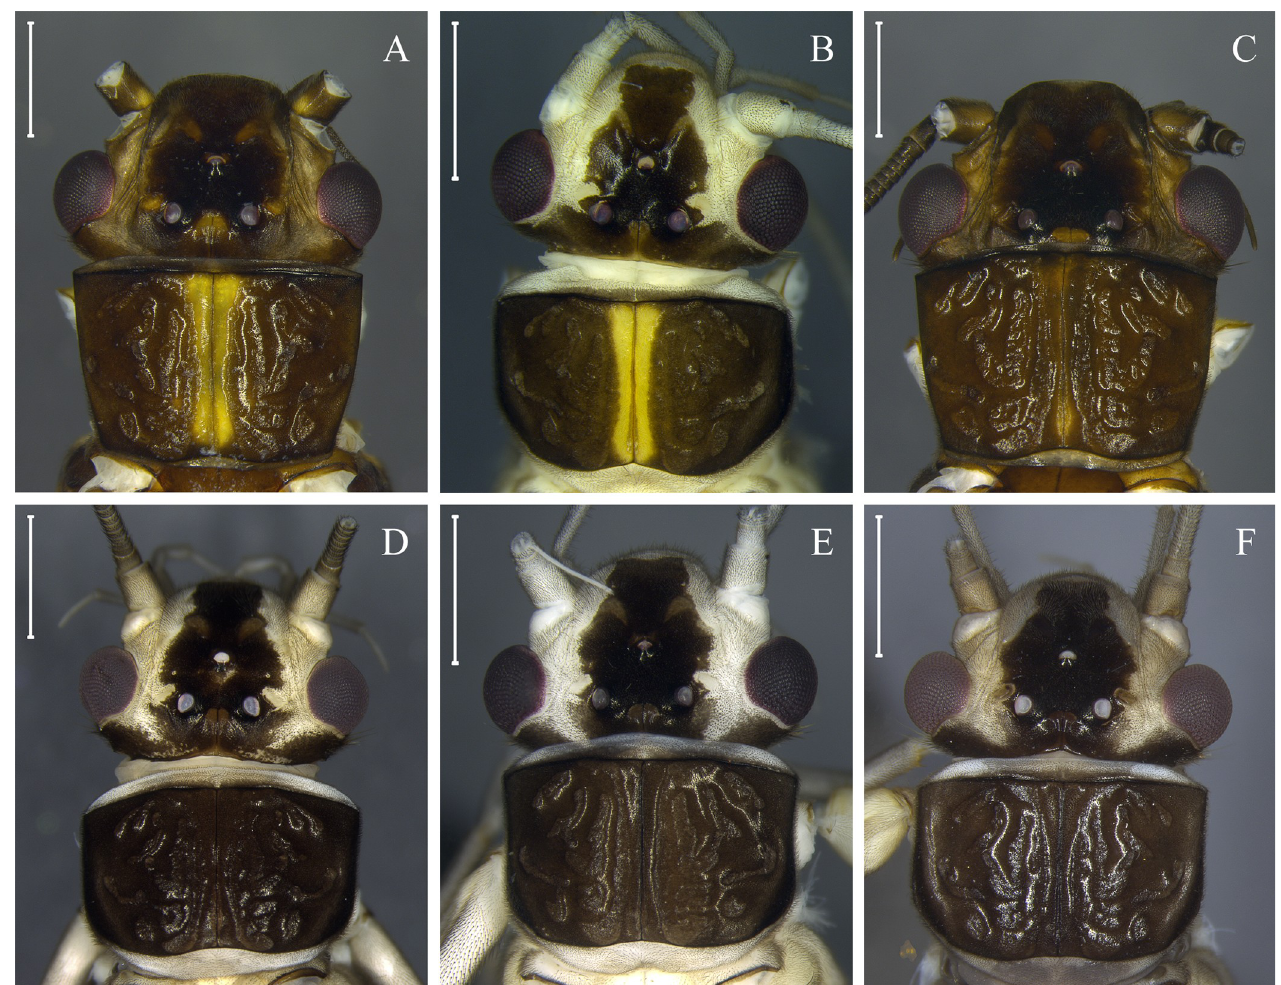
Fig 5. Morphological variation within cluster Kempnyia neotropica + K . petersorum . Head and pronotum of adult females (A and C) and teneral adult female (B) of K . neotropica . Head and pronotum of adult males (D–F) of K . petersorum according to description by Froehlich [70]. Scale: 1 mm.